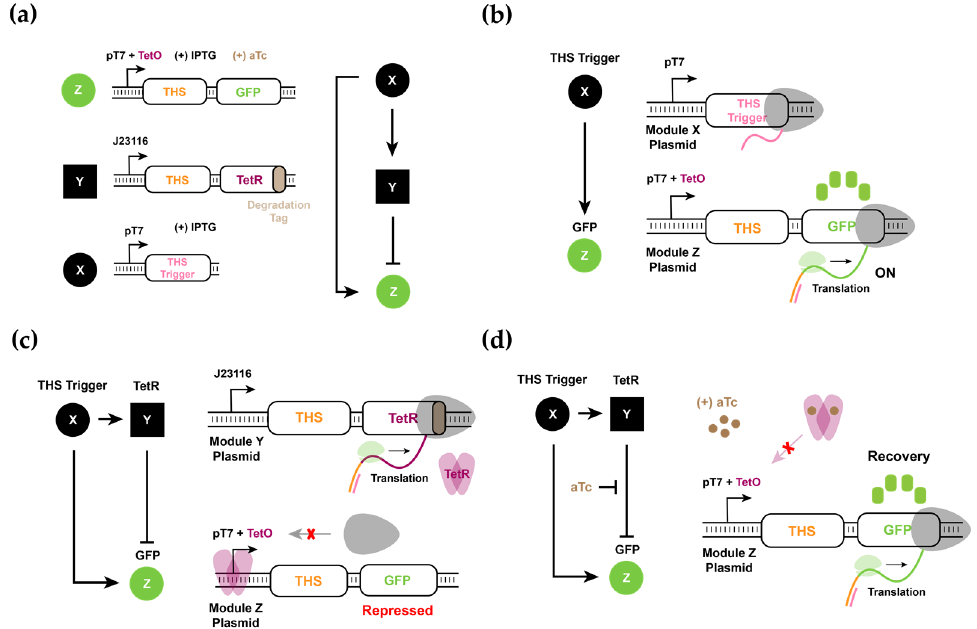
Figure 6. Architecture of RNA–protein hybrid IFFL circuit composed of THS and TetR regulation. ( a ) Detailed node constructs of RNA–protein hybrid IFFL circuit. Node Z contains the THS-GFP under the control of pT7 with TetO. Node Y contains the THS-TetR (with degradation tag) expressed under the constitutive promoter J23116. Node X contains the THS trigger expressed by pT7. ( b ) Schematic of the activation by X on Z. In the presence of the THS trigger, the start codon and RBS are exposed, thereby allowing translation of GFP protein. ( c ) Schematic of the inhibition by Y on Z. In the presence of THS trigger, TetR can be expressed, which binds to TetO within pT7 and blocks RNAP access to plasmid Z. In this case, the GFP expression will be repressed. ( d ) Schematic of aTc treatment in RNA–protein hybrid IFFL circuits. Even when the promoter is blocked by TetR, aTc treatment can release TetR from TetO within pT7 and GFP expression can be restored.